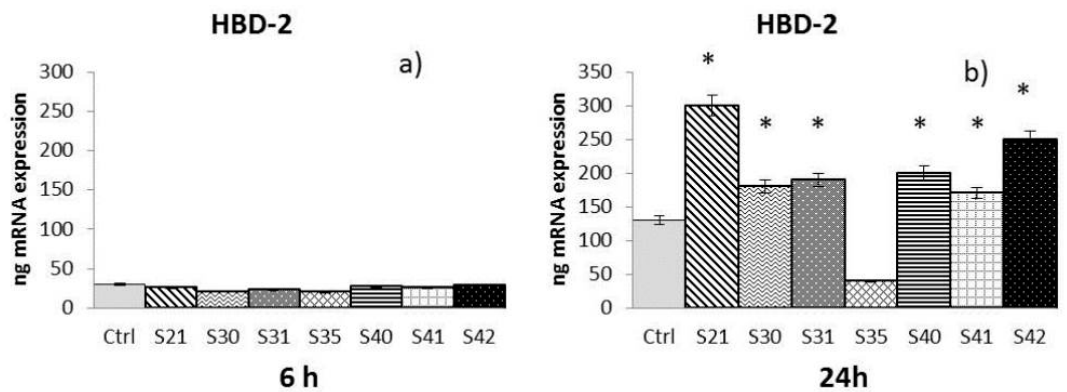
Figure 5. mRNA expression of HBD-2 from HaCat cells treated with S21, S30 , S31, S35, S40, S41 and S42 non-woven tissue bio-composites (10 µ g/mL) for 6 h ( a ) and 24 h ( b ). Data are mean ± SD of values calculated on two different experiments. *P < 0.05 compared to Ctrl.